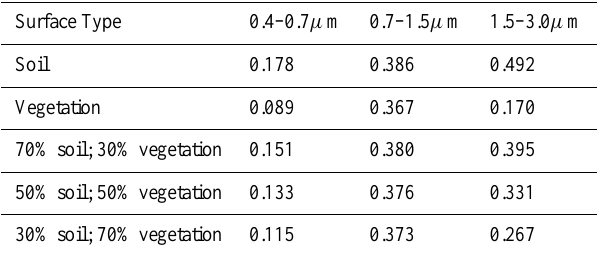
Fig. 1. Comparison of aerosol forcing over the ocean as compared to that over land. The values represent the range of aerosol forc- ing for different surface types such as soil, vegetation and various combinations of the two.